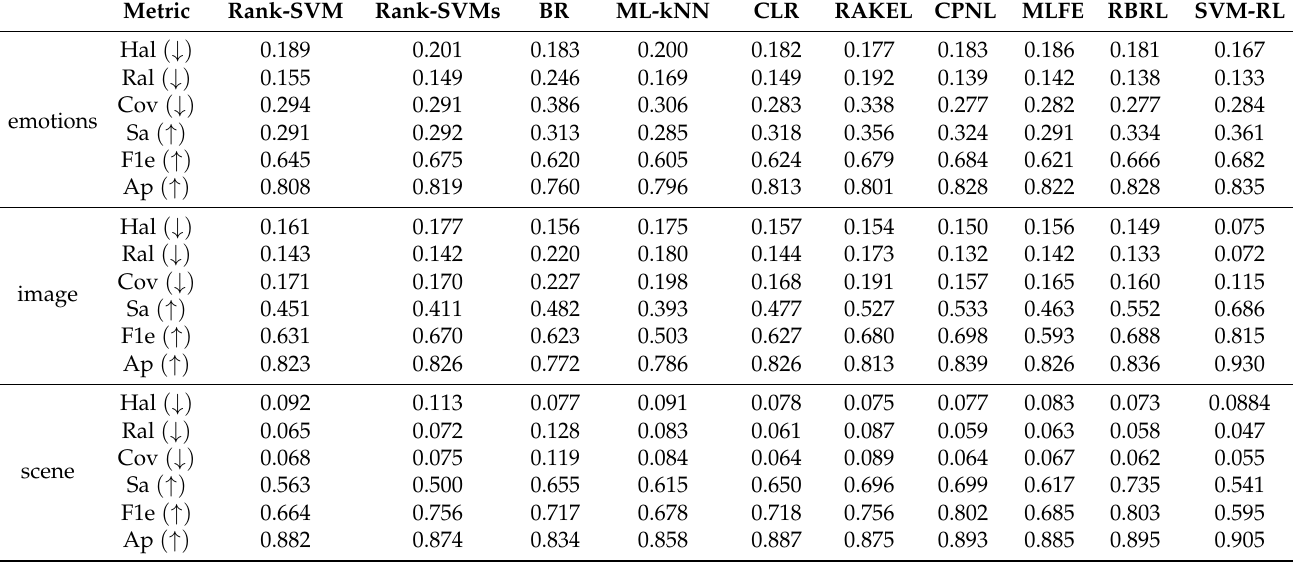
Table 4. Experimental results of each benchmark approach (mean) on four multi-label datasets. ↓ ( ↑ ) indicates the smaller (larger) the